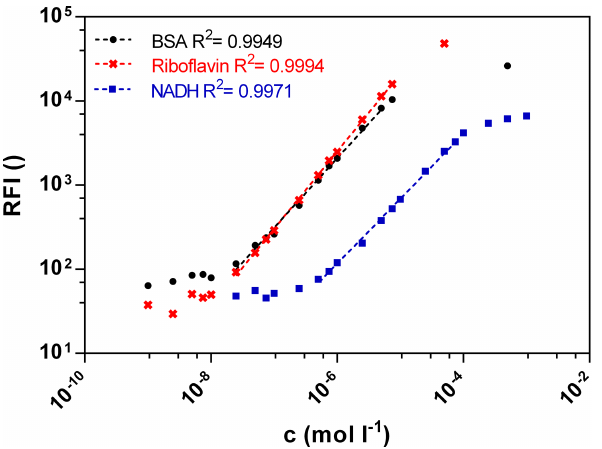
Figure 2. Calibration curves of BSA (Ex280 / Em340), riboflavin (Ex450 / Em525) and NADH (Ex365 /